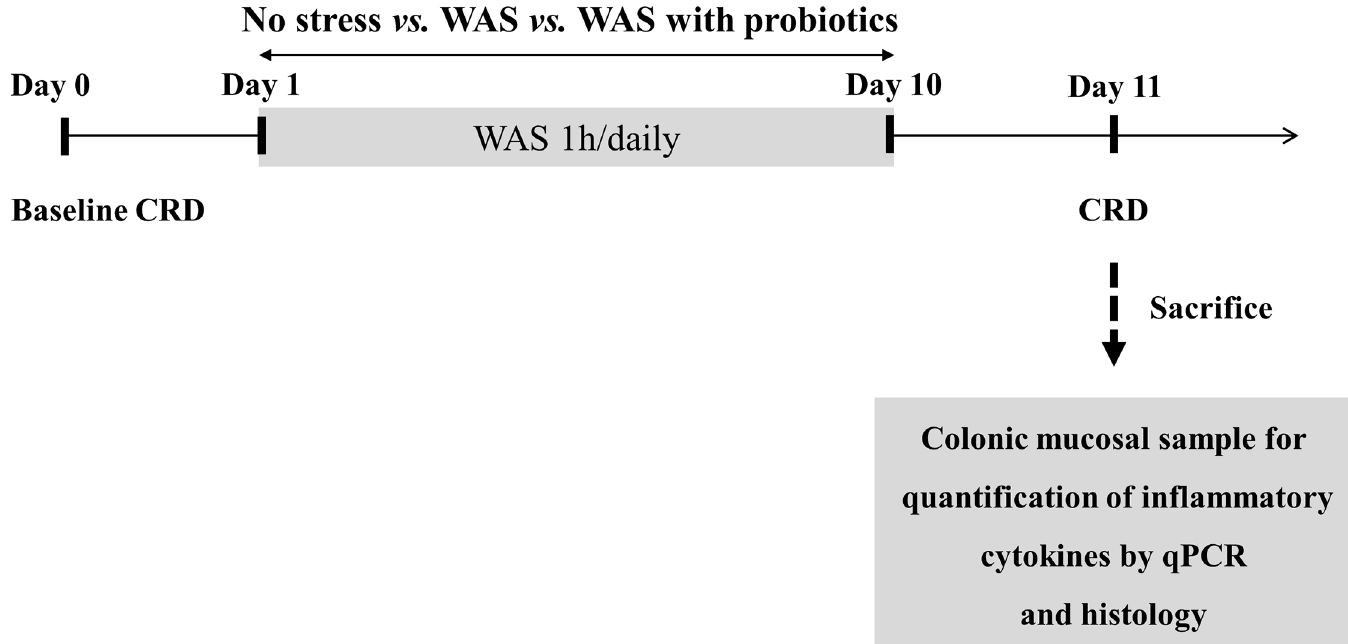
Fig 1. Experimental design. CRD, colorectal distention; WAS, water avoidance stress; qPCR, quantitative polymerasechain reaction.